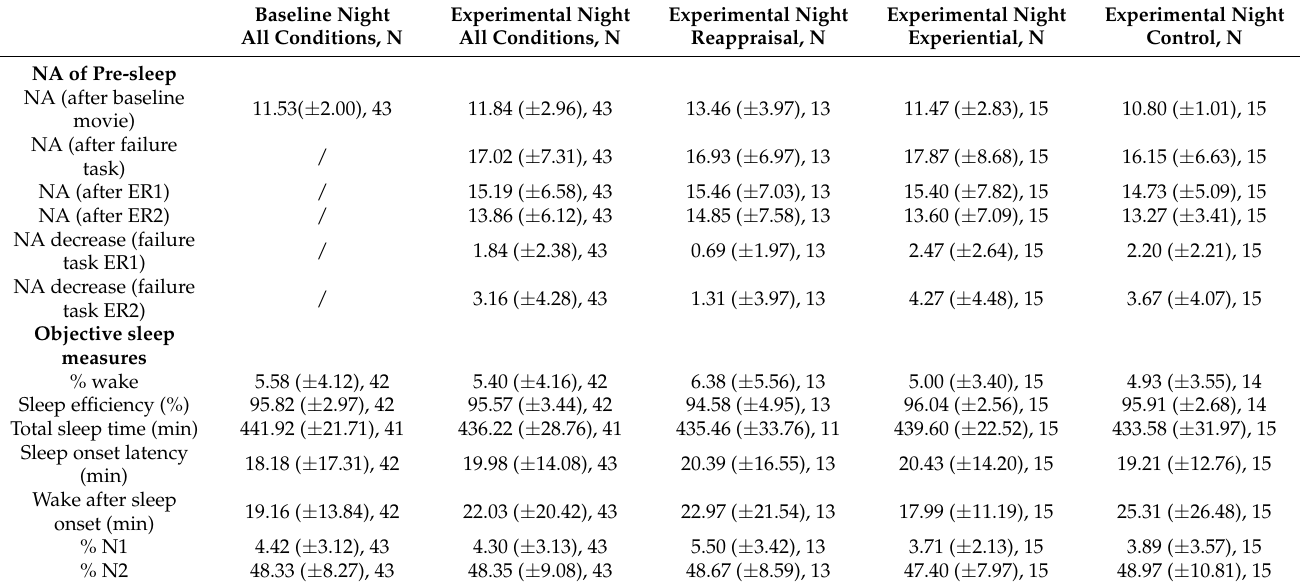
Table 2. Means and standard deviations for emotional experience and objective sleep data for both the baseline and experimental night and for the cognitive reappraisal, experiential emotion regulation, and control condition. Final sample size (N) was also provided for both the baseline and experimental